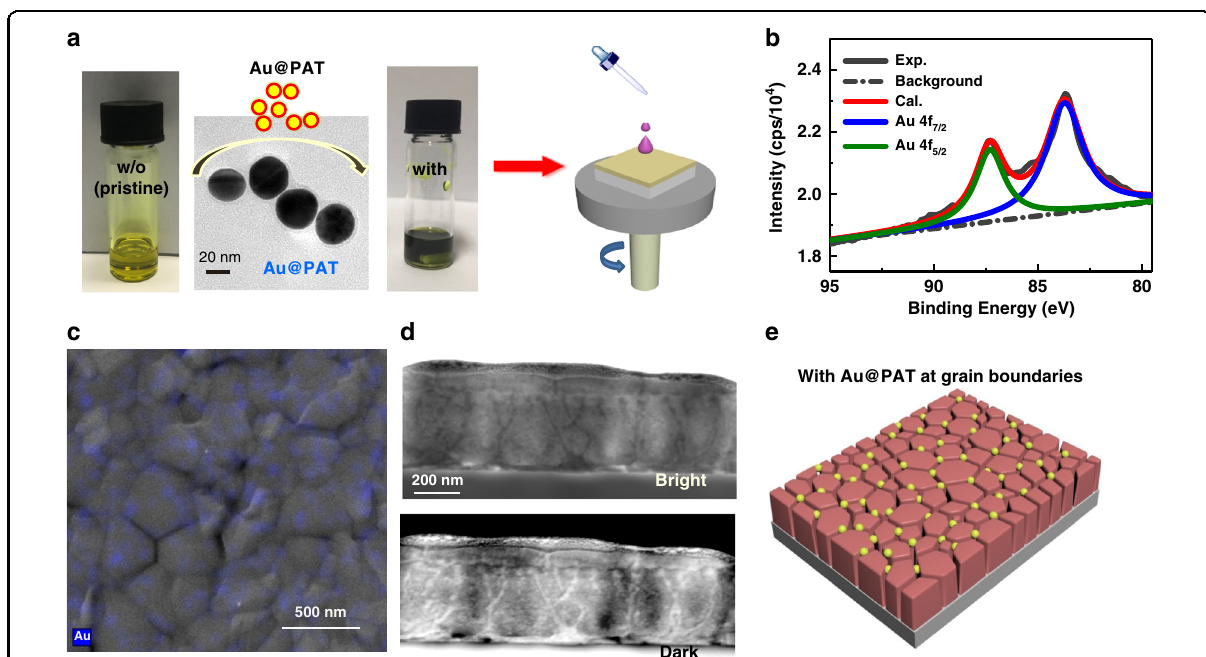
Fig. 1 Preparation and distribution characterization of Au@PAT-modi fi ed perovskite fi lms. a Addition of Au@PAT NPs (2 mg ml − 1 ) into the perovskite precursor solution and the corresponding images before and after doping. The inset shows the TEM micrograph of as-synthesized Au NPs coated with ~2 nm PAT. b XPS spectra of Au 4 f obtained from perovskite fi lms with the inclusion of Au@PAT NPs (2.0 mg ml − 1 ). c EDS mapping (in SEM mode) of Au in the Au@PAT-decorated perovskite fi lm. d ABF (Bright) and HAADF (Dark) STEM images of the perovskite fi lm with Au@PAT additives. e Schematic distribution of Au@PAT additives within perovskite (Supplementary Fig. S8). After fi ne-tuning the concentra- tion of NPs from 0.4 to 2.0 mg ml − 1 (see Supplementary Fig. S9 and Table S1), the champion device comprising 0.8 mg ml − 1 Au@PAT presents a J of 21.71 mA cm − 2 , a SC